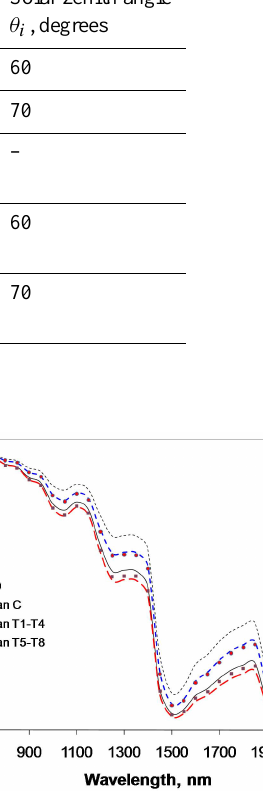
Fig. 14. Hemispherical spectral albedos calculated for selected snow pits of the C and T groups, using the DIR70diff source. Mean values for the three pit groups are also